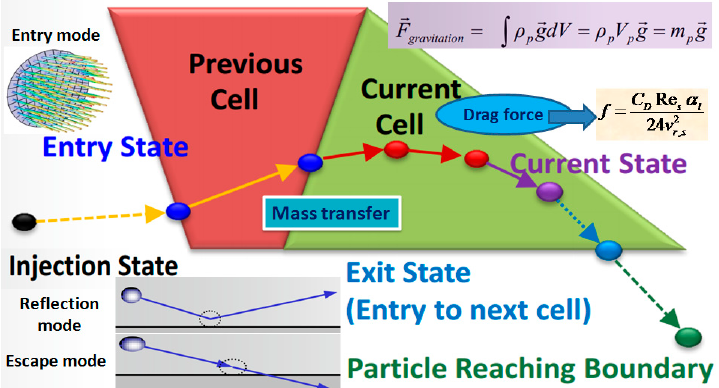
Figure 3. Particle phase movement mechanism.